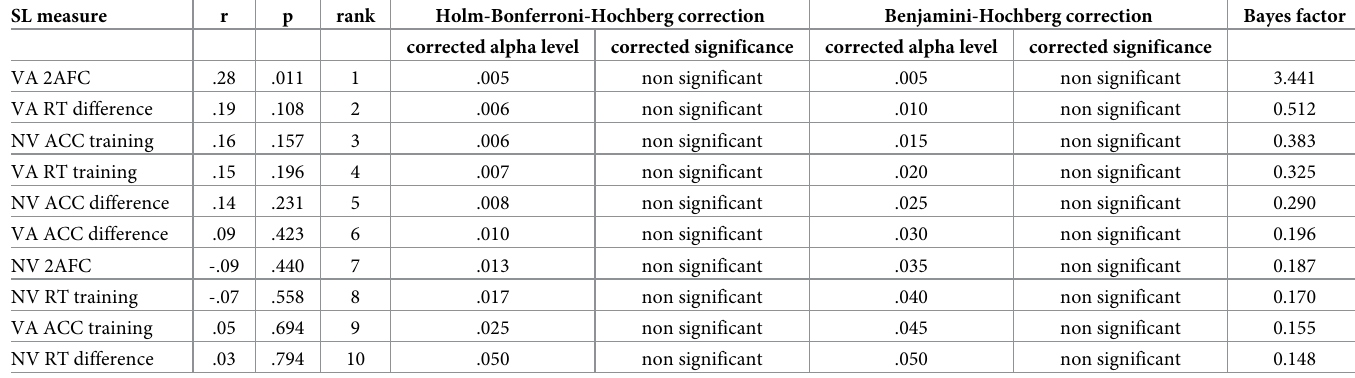
Table 3. Holm-Bonferroni-Hochberg and Benjamini-Hochberg corrections and Bayes factors of the correlation analyses between reading fluency and statistical learning measures. SL